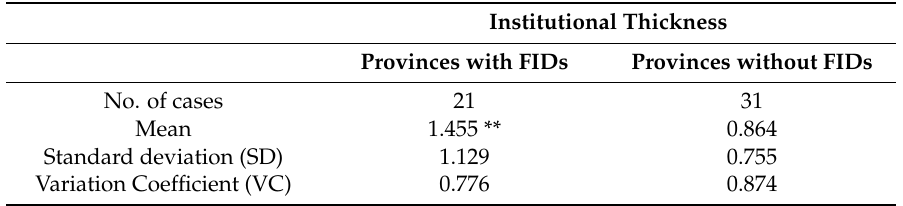
Table 3. Comparison between provinces with/without districts and food industry